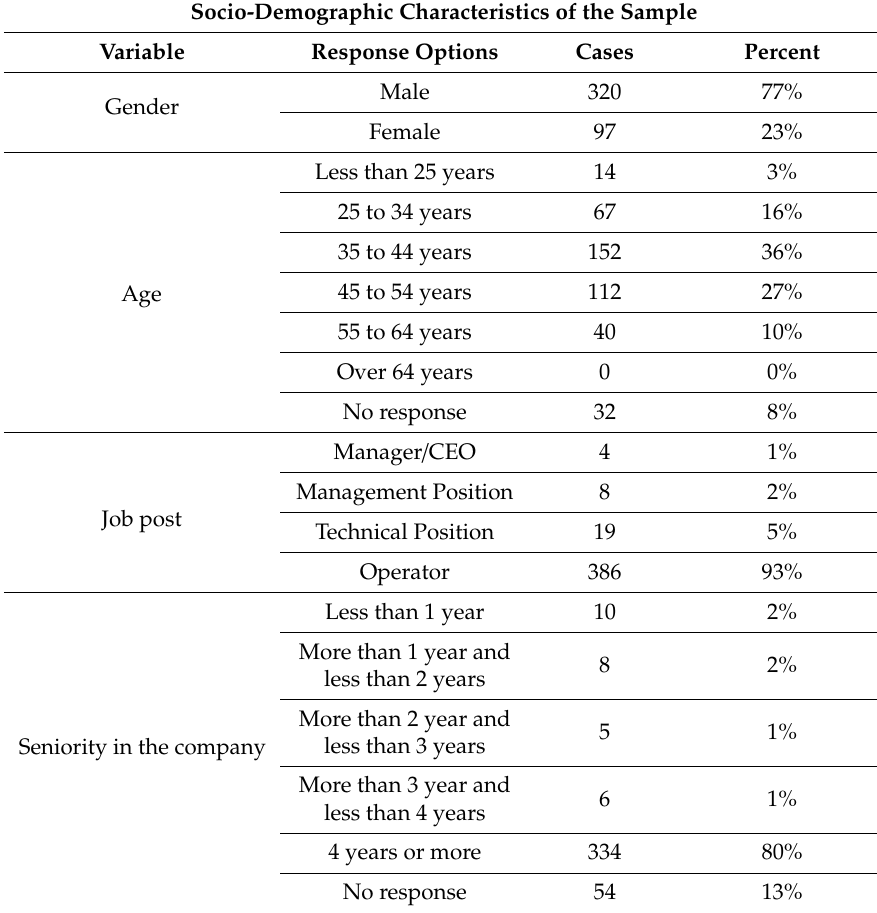
Table 1. Characteristics of the sample of workers (n =